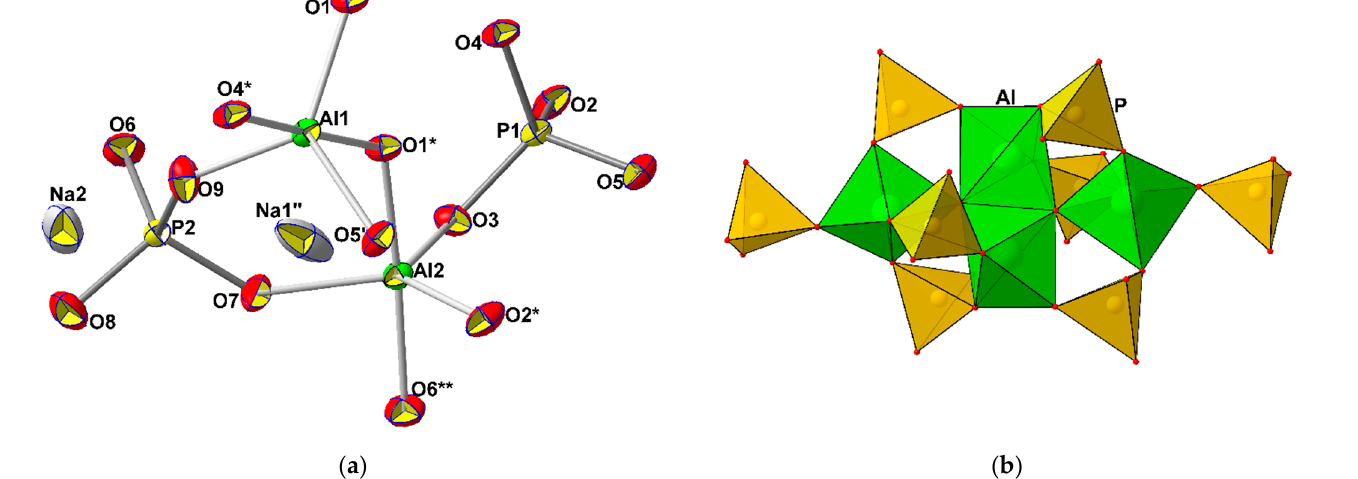
Figure 2. ( a ) The main structural units of the Na 2 Al 2 O(PO 4 ) 2 ·0.12H 2 O. Displacement ellipsoids are drawn at the 90% probability level. Symmetry operations: (*) – x , 1 – y , 1 – z ; (**) x , 1½ – y , ½+ z ; (’)— x , – ½ + y , 1½ – z ; (”) 1 – x , –0.5 + y , 1½ – z . ( b ) The tetramer of AlO 5 bipyramids sharing edges and vertices, and adjacent PO 4 tetrahedra.